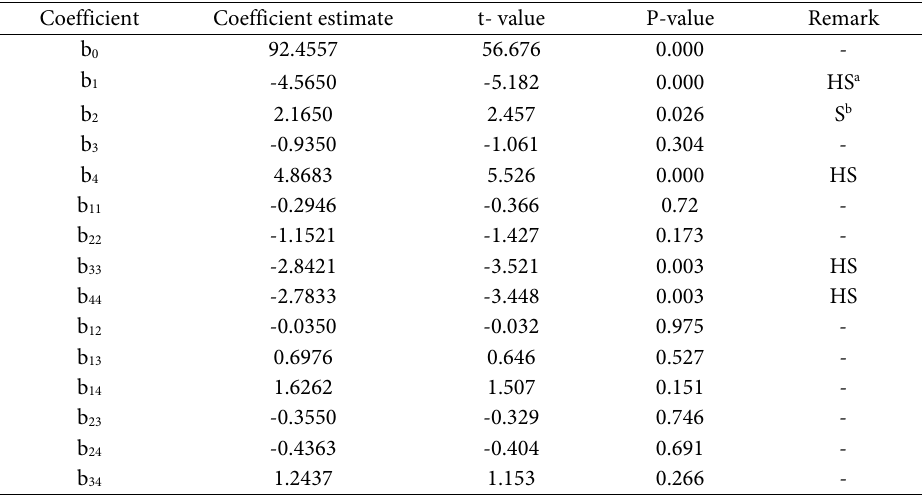
Table 3. Estimated model coefficients for removal of MO and corresponding T and P values.